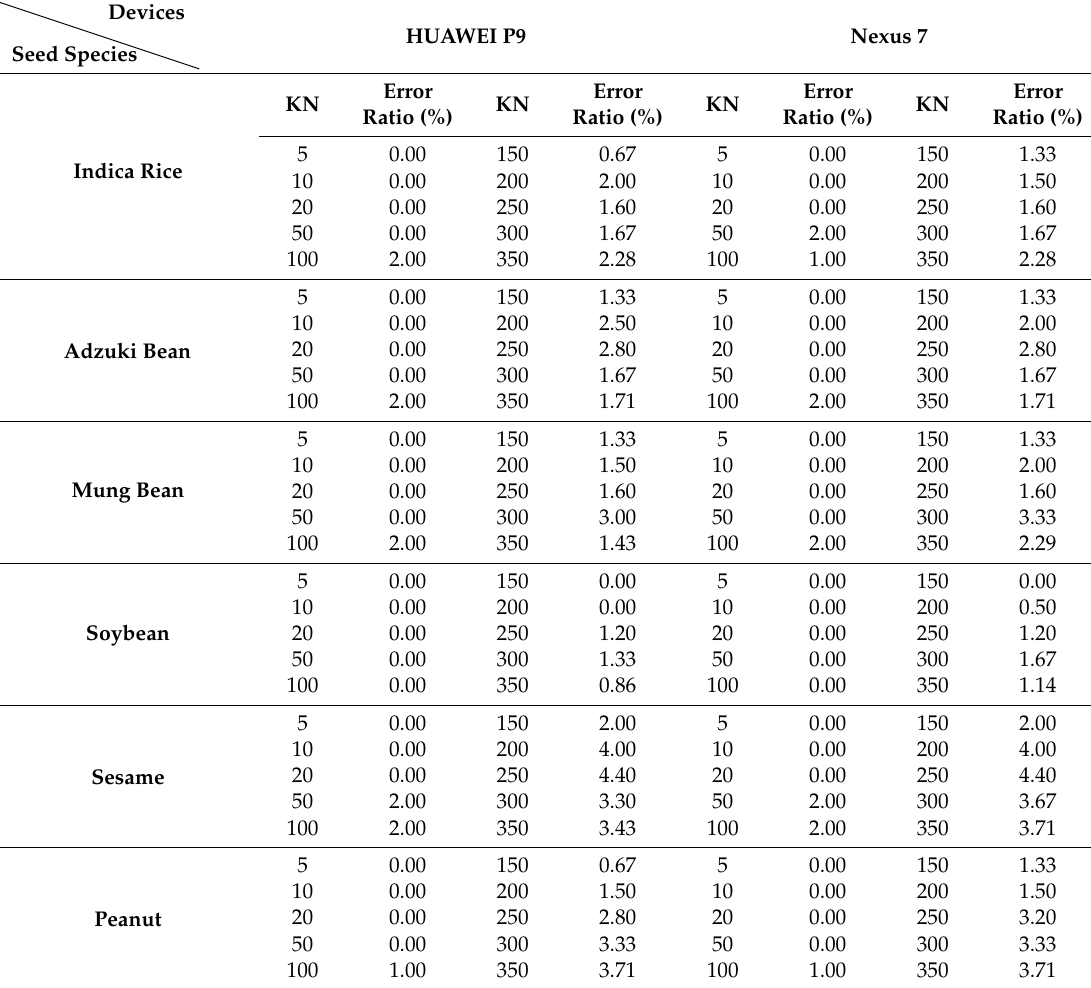
Table 2. The performance evaluation of the accuracy of kernel counting using the “gainTKW” application on two different Android devices using six species of kernels (KN means kernel number). SpeciesDevices HUAWEI P9 Nexus Seed